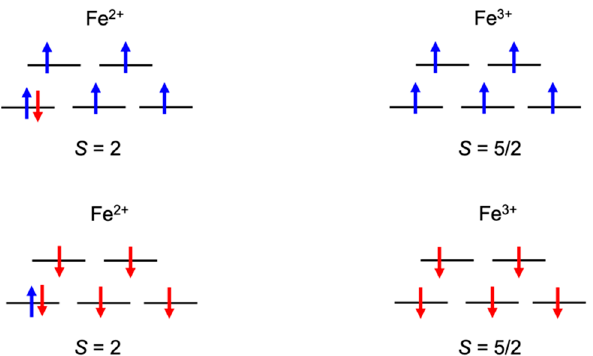
Figure 2. The scheme shows the antiferromagnetic coupling arrangement (total S = 0) of four high- spin iron centers consisting of two ferrous (Fe 2+ , d6, S = 4/2 = 2) iron centers and two ferric (Fe 3+ , d5, S = 5/2) iron centers.